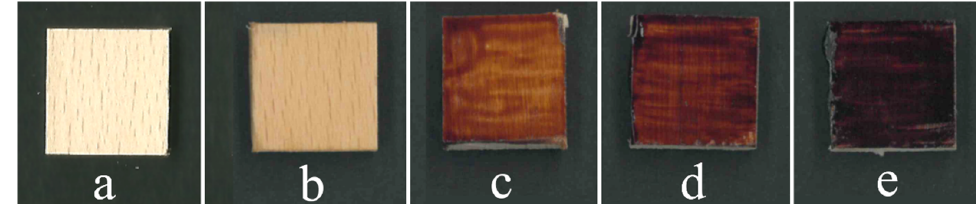
Figure 1. Beech wood samples before ( a ) and after coating application ( b – e ). ( a ) W-R, ( b ) WPU-R, ( c ) WPU-3:1, ( d ) WPU-1:1 and ( e ) WPU-1:3. Table 2. Color coordinates based on CIELAB color space of wooden samples before coating application (W-R) and after coating application. Δ E* was calculated using the difference between uncoated (W-R) and coated wood samples. Statistical differences are reported as: *** p < 0.001, ** p < 0.01 and * p < 0.05.